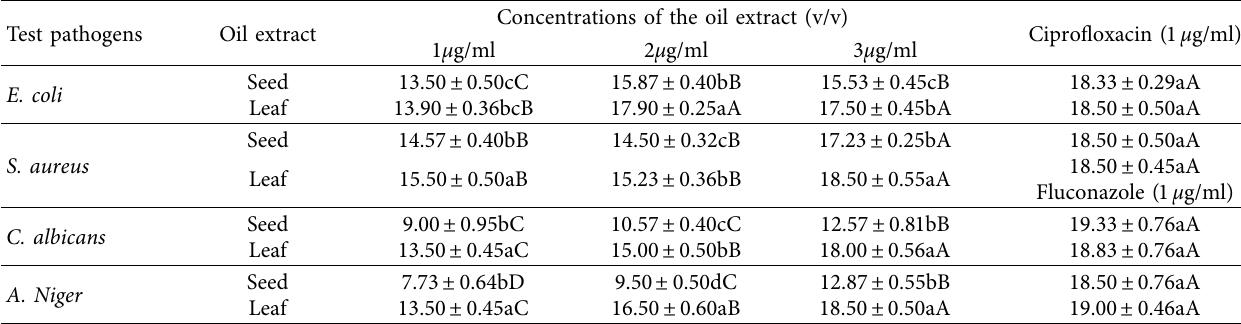
Table 3: Antimicrobial Activities oil extracts from garden cress seed and leaf oil extract as mean diameter of zone of inhibition against test pathogenic microbial spp.